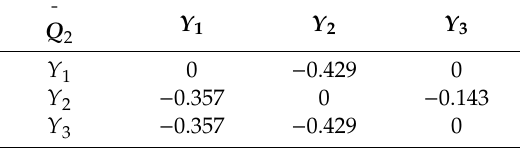
Table 11. The normalized regret matrix Q 2 .